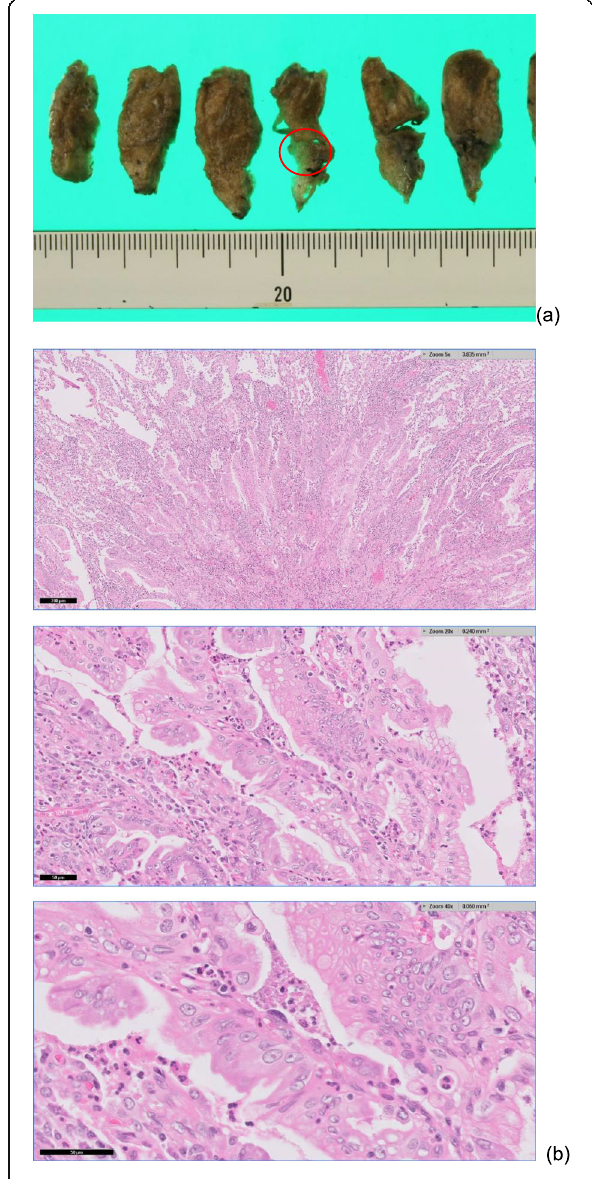
Fig. 4 Histopathological findings with a the tumor location indicated by the circle and b hematoxylin-eosin stained tissue with alveolar replacement and proliferation of atypical gland ducts with irregular mucus-containing